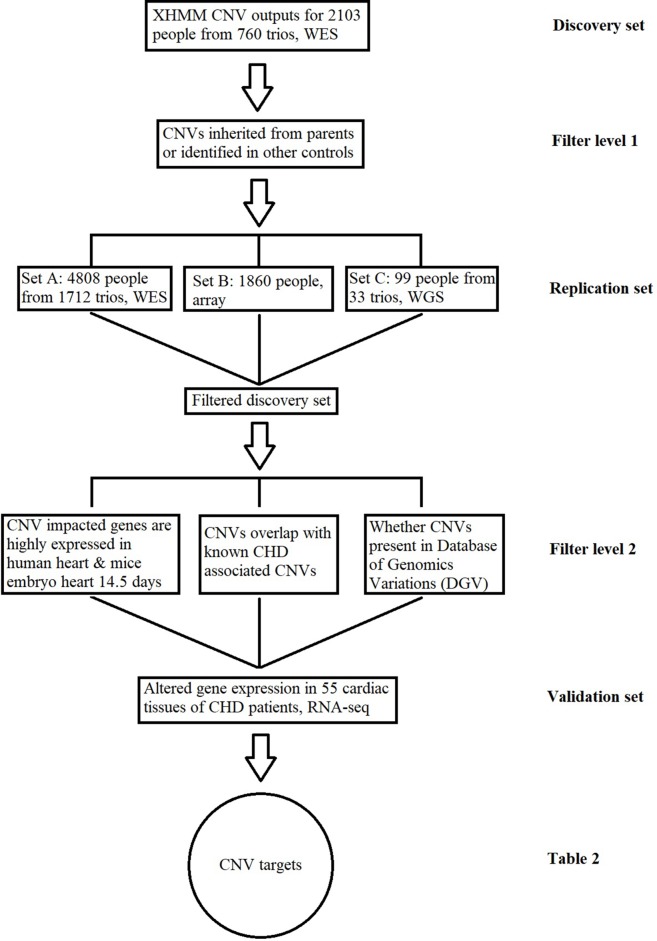
Copy number variant (CNV) identification and functional validation pipeline. This figure describes the conceptual pipeline for CNV target selection based on large sequencing/chip data of different platforms. The CNVs for the whole-exome sequencing (WES) data in the discovery set from 760 trios were detected based on the XHMM pipeline. Any inherited CNVs or CNVs identified in independent healthy controls were filtered at the first level; the remaining CNVs were further replicated in three exclusive datasets at different platforms and checked through previously reported results for further confirmation; the expressions for CNV-impacted genes were compared between the patients with/without the CNV based on RNA-Seq of cardiac tissues. CNVs associated with altered gene expression are listed in
Table 2
 as the targets for CHD.